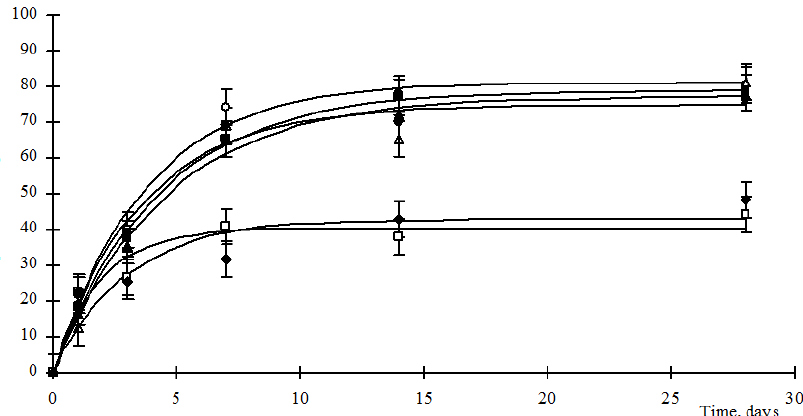
Figure 6. Strength of cement stone modified with barium hydrosilicates and zinc hydrosilicates, where: ○ — content of hydrosilicates of zinc 0.5%; ●— content of hydrosilicates of zinc 1%; ■ — content